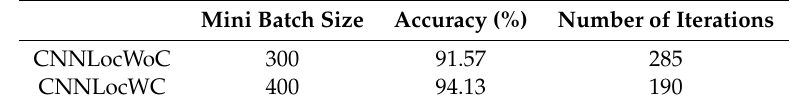
Table 7. Adam’s accuracy on the validation data using a grid of size 2 m × 2 m and 10 anchors.